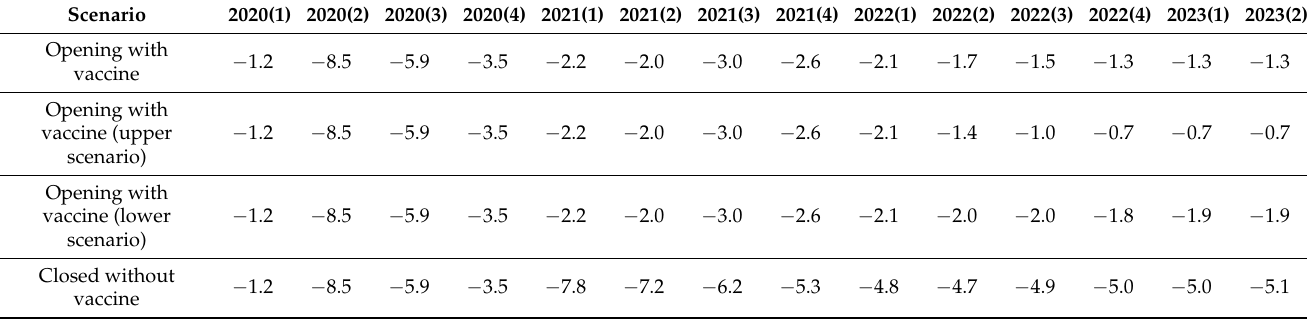
Table A1. Percentage points (%) change in GDP with and without vaccine vs. no COVID scenario.